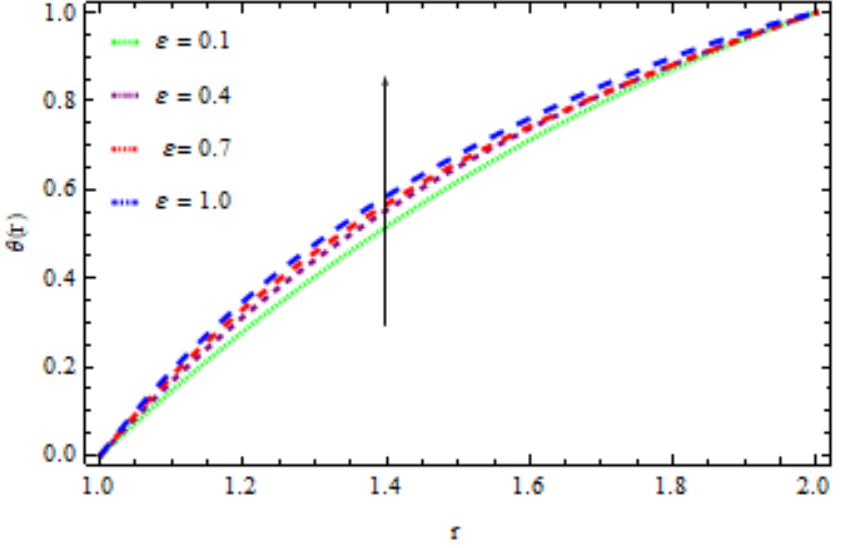
Figure 11. The influence of ε on temperature distribution for Reynolds’ model (RM) when β 0 = 1.2, m = 0.1, Q = 0.1, B r = 0.5, M = 0.5, N = 0.3, K p = 0